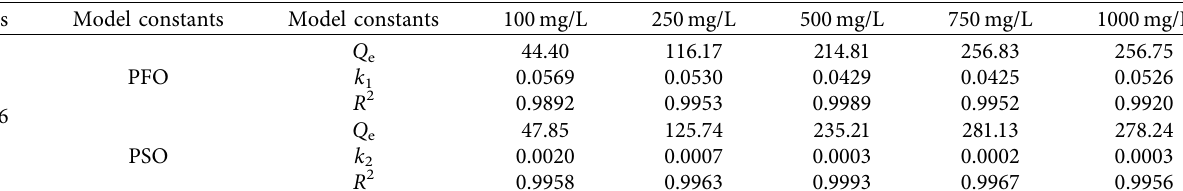
Table 4: PFO and PSO kinetic model constants.